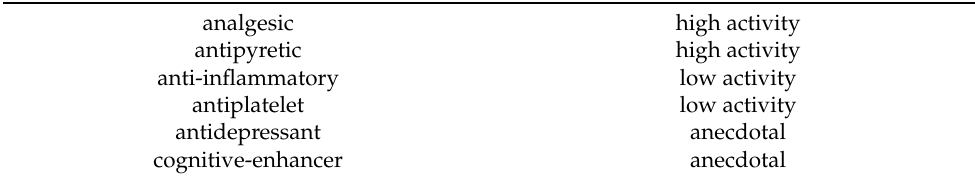
Table 1. Clinical pharmacological activities of